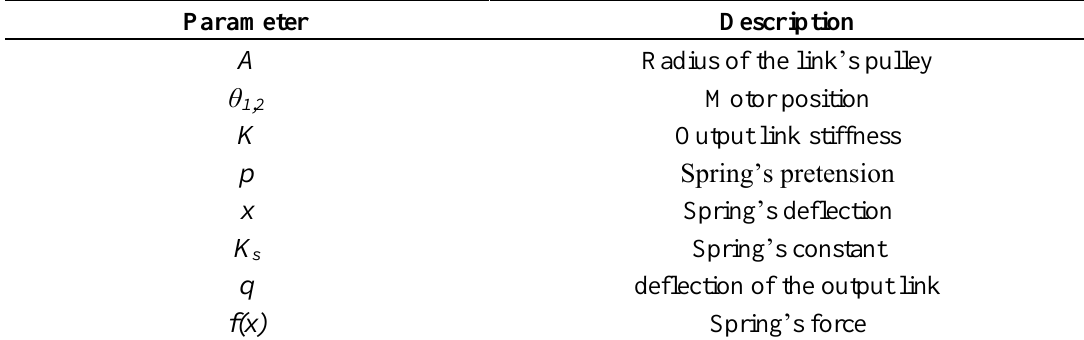
Table 1. Description of the